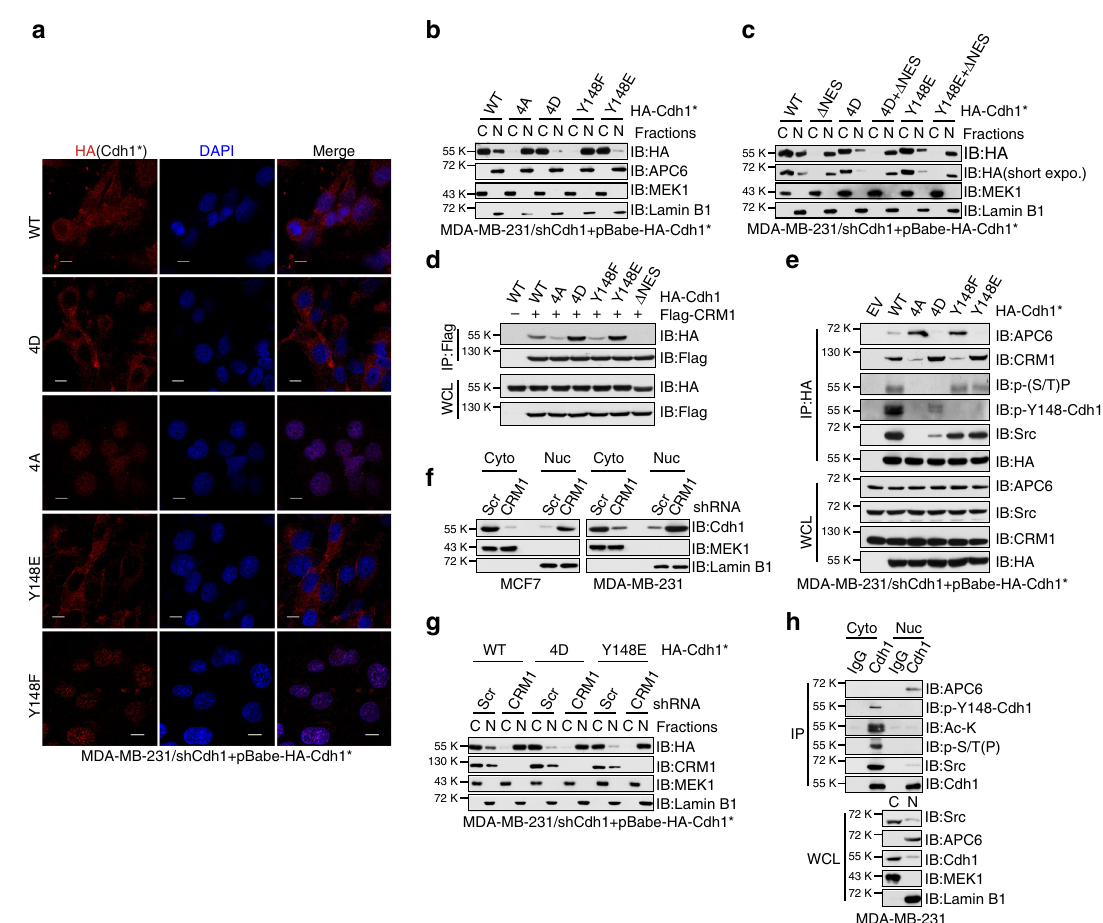
Fig. 7 N -terminal phosphorylated Cdh1 is translocated to the cytoplasm by CRM1. a Immuno fl uorescent staining of sh Cdh1 -MDA-MB-231 cells stably expressing WT-, 4D-, 4A-, Y148E-, or Y148F-Cdh1 using anti-HA(Cdh1) antibody, DAPI was used for DNA staining. *Cdh1 cDNA used in this experiment has been mutated to escape sh Cdh1 -mediated gene silencing. Scale bar, 50 μ m. b MDA-MB-231 cells generated in ( a ) were subjected to cytoplasm/ nucleus fractionation followed by immunoblot (IB) analysis. c sh Cdh1 -MDA-MB-231 cells stably expressing the indicated Cdh1 retroviral constructs were subjected to cytoplasm/nucleus fractionation followed by IB analysis. d IB analysis of whole-cell lysates (WCL) and anti-Flag immunoprecipitates (IP) derived from 293T cells transfected with Flag-CRM1 and the indicated HA-Cdh1 constructs. e IB analysis of WCL and anti-HA IP derived from MDA-MB- 231 cells generated in ( a ). f MCF7 and MDA-MB-231 cells were infected with shScr or sh CRM1 lentiviral shRNA constructs. The infected cells were selected with 1 μ g ml − 1 puromycin for 72 h before harvest for cytoplasm/nucleus fractionation and IB analysis. g sh Cdh1 -MDA-MB-231 cells stably expressing WT-, 4D-, Y148E-Cdh1 were infected with shScr or sh CRM1 lentiviral shRNA constructs. The infected cells were selected with 1 μ g ml − 1 puromycin for 72 h before harvest for cytoplasm/nucleus fractionation and IB analysis. h MDA-MB-231 cells were subjected to cytoplasm/nucleus fractionation followed by anti-Cdh1 IP and IB analyses